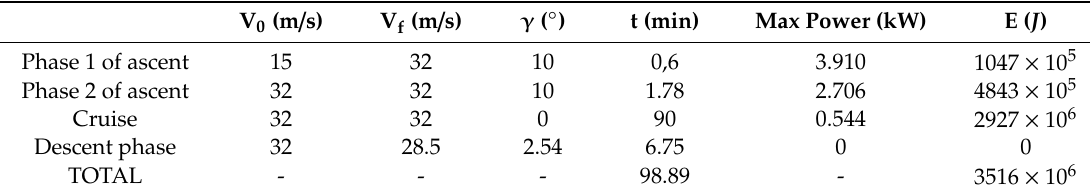
Table 10. Energy requirements for each phase of the main flight